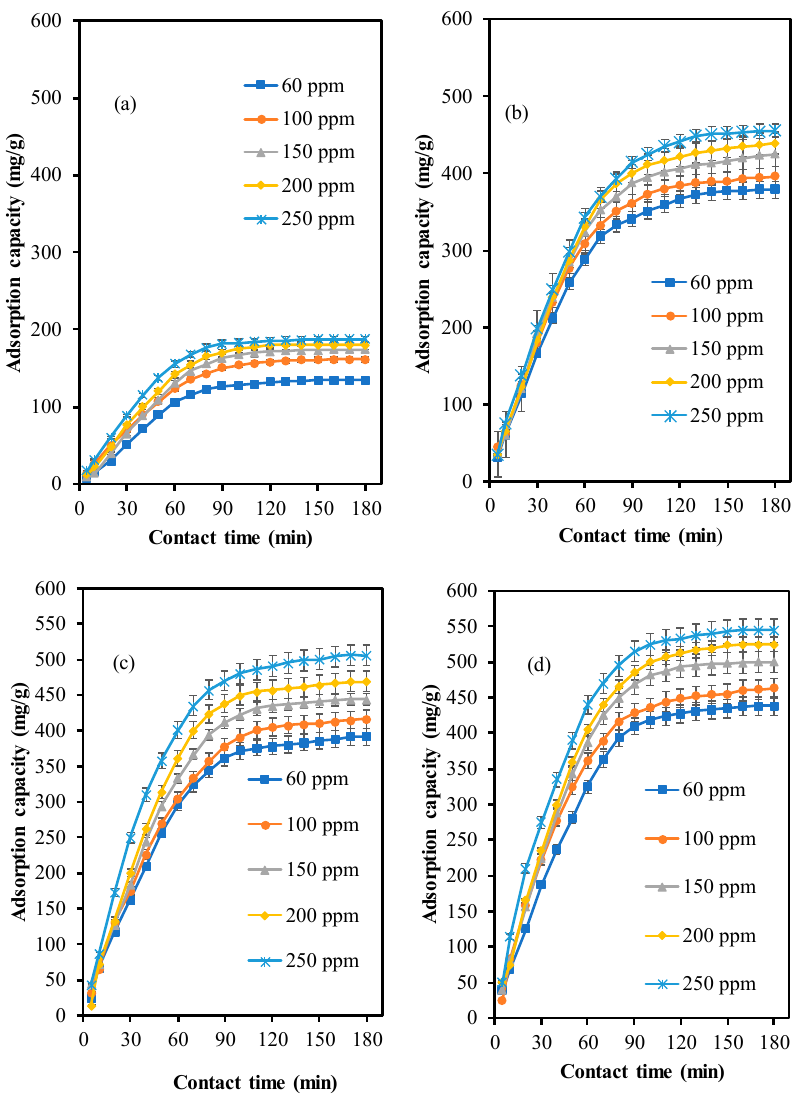
Figure 8. E ff ect of initial MB concentration over the adsorbents ( a ) ZSM-5 comm ( b ) ZSM-5 deAl Figure 8. Effect of initial MB concentration over the adsorbents ( a ) ZSM ‐ 5 comm ( b ) ZSM ‐ 5 deAl ( c ) ZSM ‐ ( c ) ZSM-5 deSil ( d ) ZSM-5 deSil-deAl 5 deSil ( d ) ZSM ‐ 5 deSil ‐ deAl .